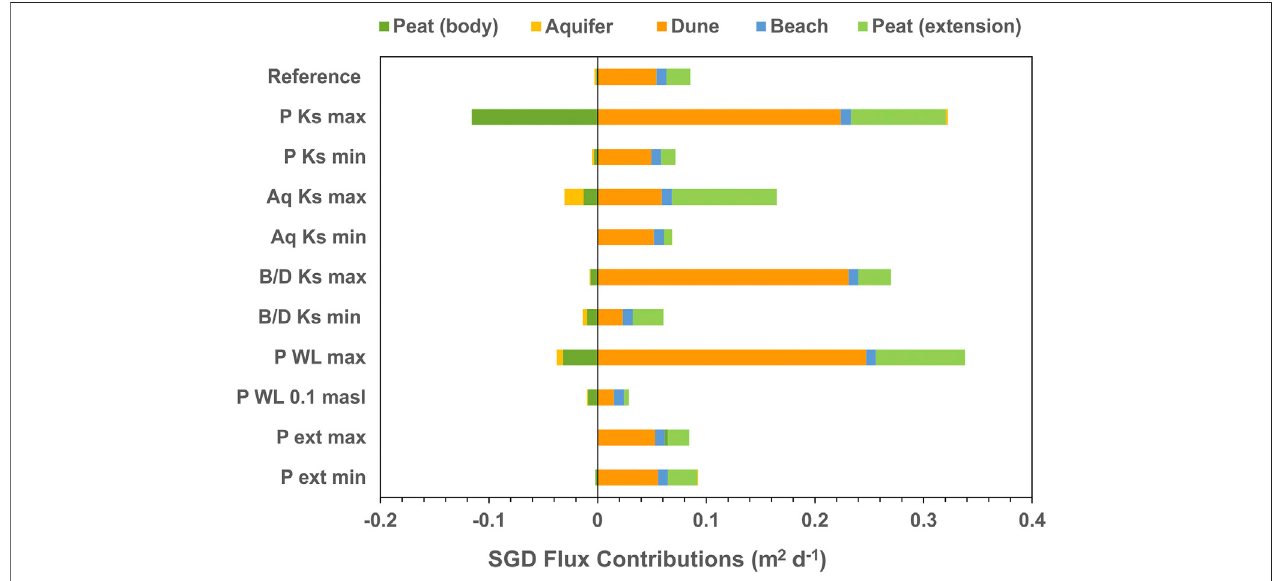
FIGURE 6 | Contributions from the dune, beach, peat body, peat extension, and aquifer sands to submarine groundwater discharge for selected scenarios. Positive fl uxesareinputswhilenegative fl uxesrepresentoutputofwaterfromthebeachsands.InPK s maxscenario,alargevolumeofwaterin fi ltratedthedunedikeand then, water fl owed down to the peat